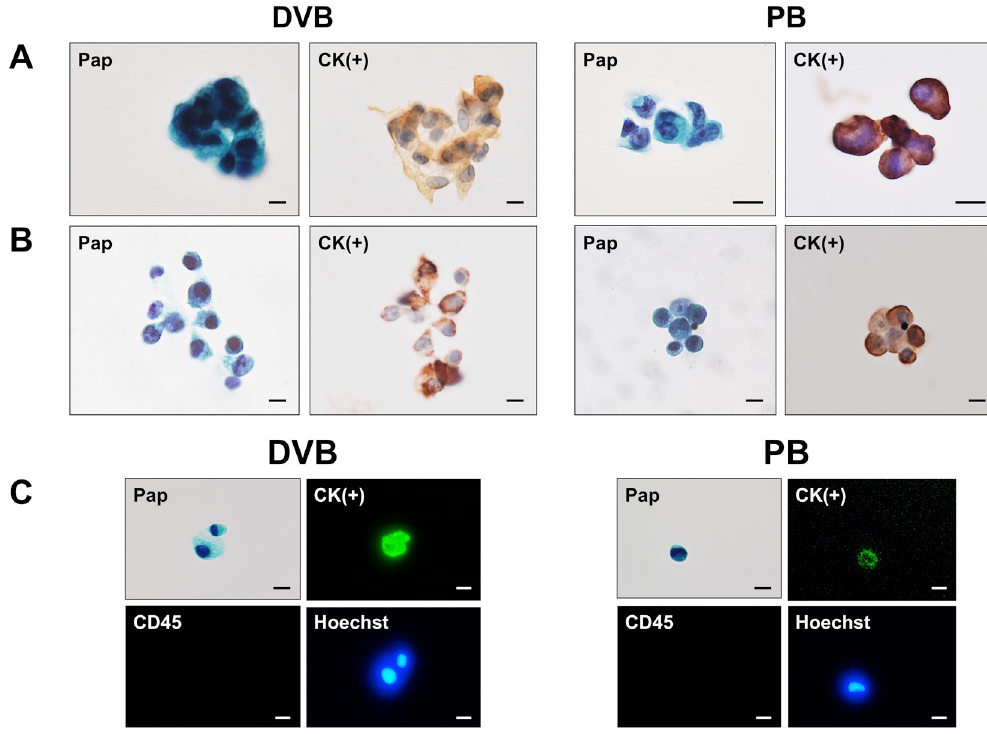
Fig 3. Identification of CTCs in peripheral blood (PB) and draining venous blood (DVB) from CRC patients. (A) Representative CTCs in DVB and PB from the same patient detected by pan-cytokeratin ICC and Pap staining with separate specimens. (B) Representative CTCs in DVB and PB stained by combined Pap and pan-cytokeratin ICC on the same specimen. De-stained Pap slide used for subsequent ICC. (C) Representative CTCs in DVB and PB stained by combined Pap and triple IF (Alexa Fluor 488-cytokeratin/Alexa Fluor 568-CD45/Hoechst 33342) on the same specimen. Bar = 10 μ m.